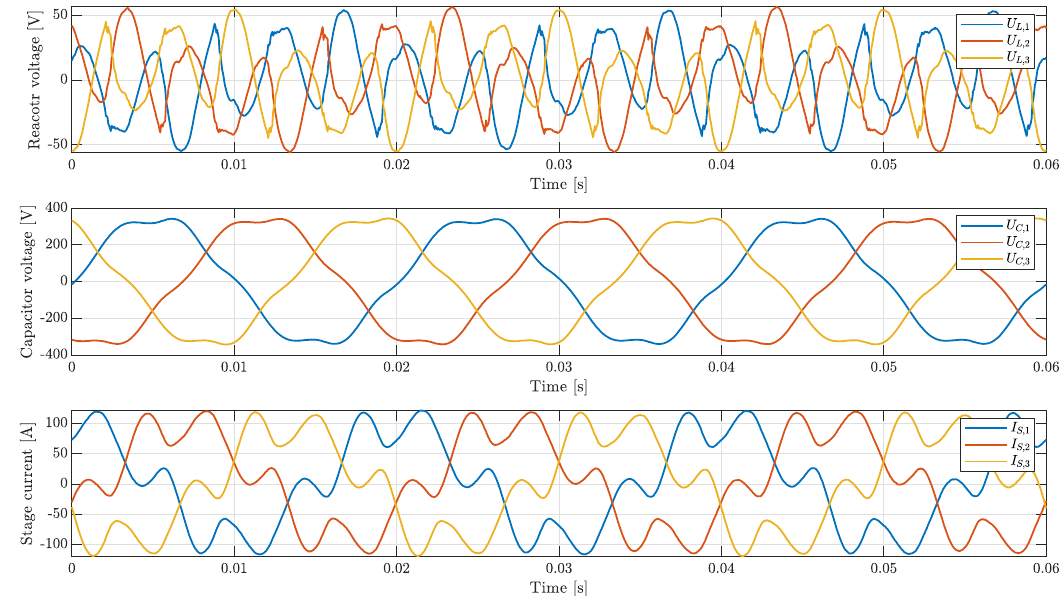
Figure 10. C1—Capacitor voltage, reactor voltage and stage current after the stage is switched